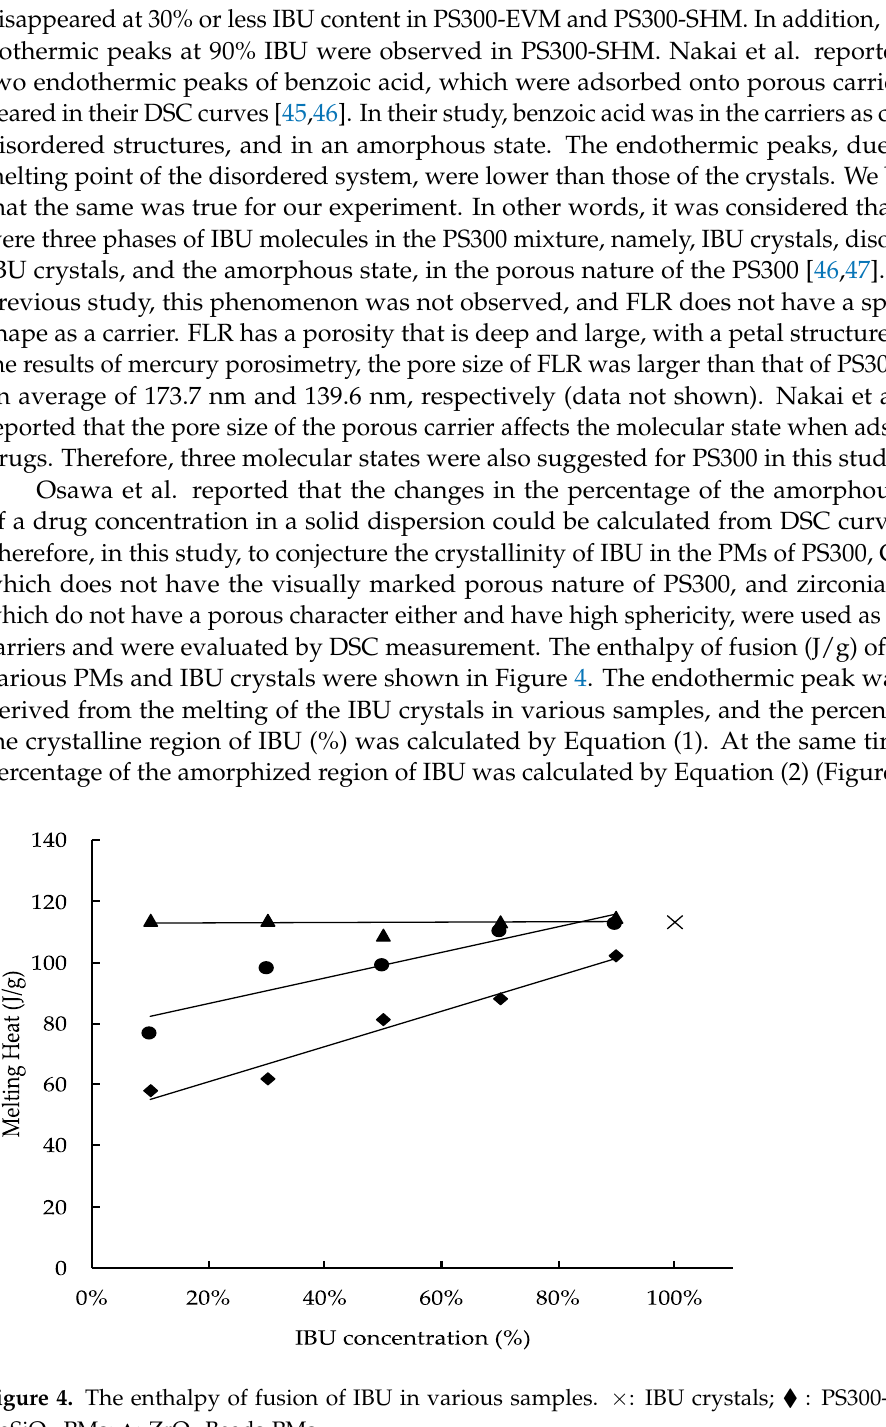
Figure 5. Percentage of the amorphized region of IBU in various samples. ○ : PS300-PMs; ×: Ca- SiO 3 -PMs; ● : ZrO 2 Beads-PMs. 3.4. Fourier-Transform Infrared Spectroscopy (FTIR) We evaluated the molecular interactions between the surface of the PS300 and IBU molecules using ATR-FTIR. On the IR spectrum of the IBU, a prominent peak of the C=O stretching vibration band at 1710 cm − 1 was observed, as shown in Figure 6a. In addition, in the IR spectrum of PS300, the peak was due to the -OH bending vibration band at 1635 cm − 1 , as shown in Figure 6a. All samples had a peak in the PMs due to the C=O stretching vibration band at 1710 cm − 1 ; they also had a peak at 1550 cm − 1 , as shown in Figure 6b. In EVMs and SHMs, the peak at 1710 cm − 1 disappeared when the content of IBU was 10% and 30% in the mixtures, and the peak intensity of 1550 cm − 1 was stronger than at other contents of IBU, as seen in Figure 6c,d. As reported in our previous study, adsorbed IBU forms calcium salt due to the interaction between the IBU and calcium on the surface of the PS300 [37]. In this study, it was confirmed that calcium salt was formed on the surface during the adsorption of IBU onto PS300 (data not shown).